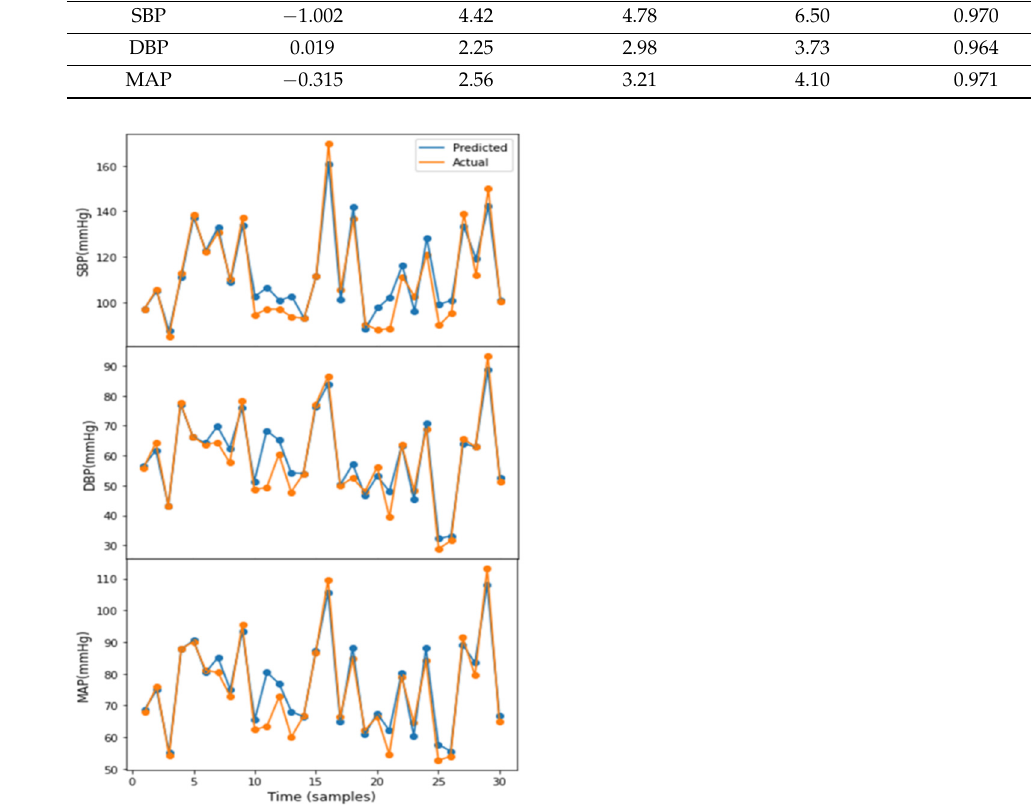
Figure 4. An example of real-time systolic blood pressure (SBP), diastolic blood pressure (DBP), and mean arterial pressure (MAP) estimation.